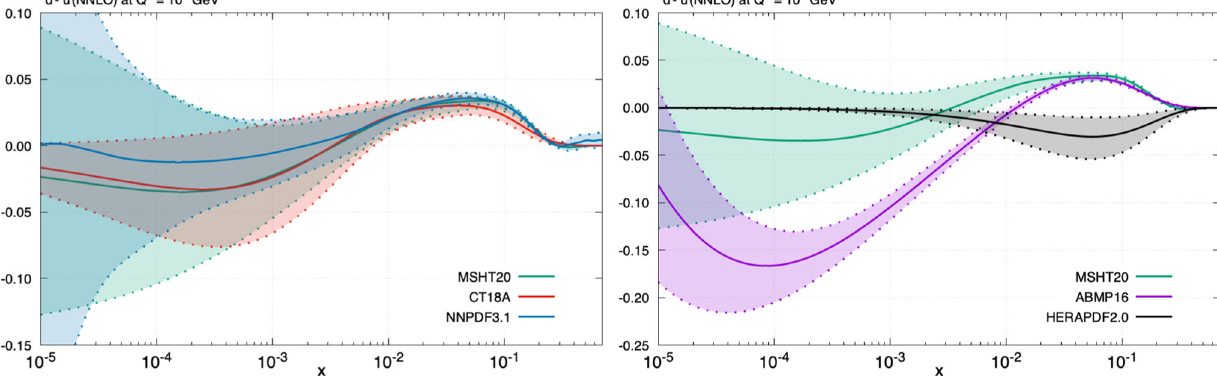
Fig. 93 ComparisonoftheMSHT20NNLO d − u PDFat Q 2 = 10 4 GeV 2 withotherrepresentativePDFsets.Thesecorrespondto α S ( M 2 in all